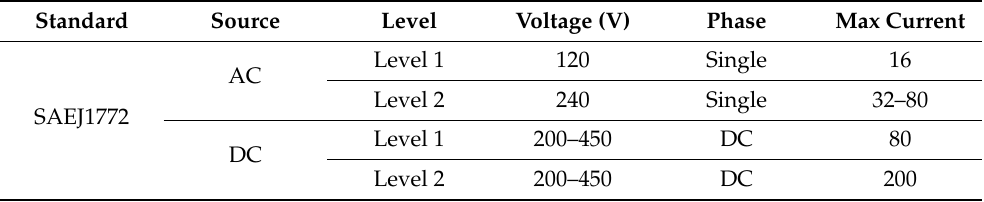
Table 1. Summary of voltage and current levels in SAEJ1772